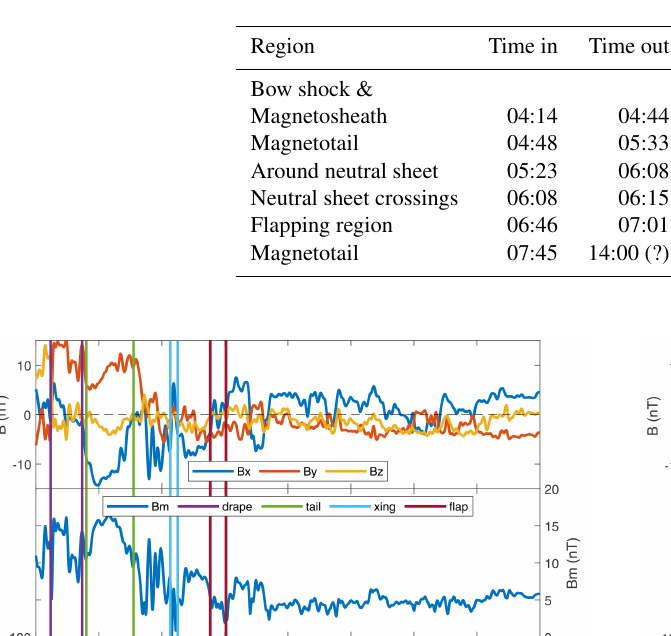
Table 1. Selected time intervals, based on the magnetometer data, showing different regions in Venus’s induced magnetosphere behind the bow shock. The distance in the tail behind Venus in X VSO is given in Venus radii, R V .